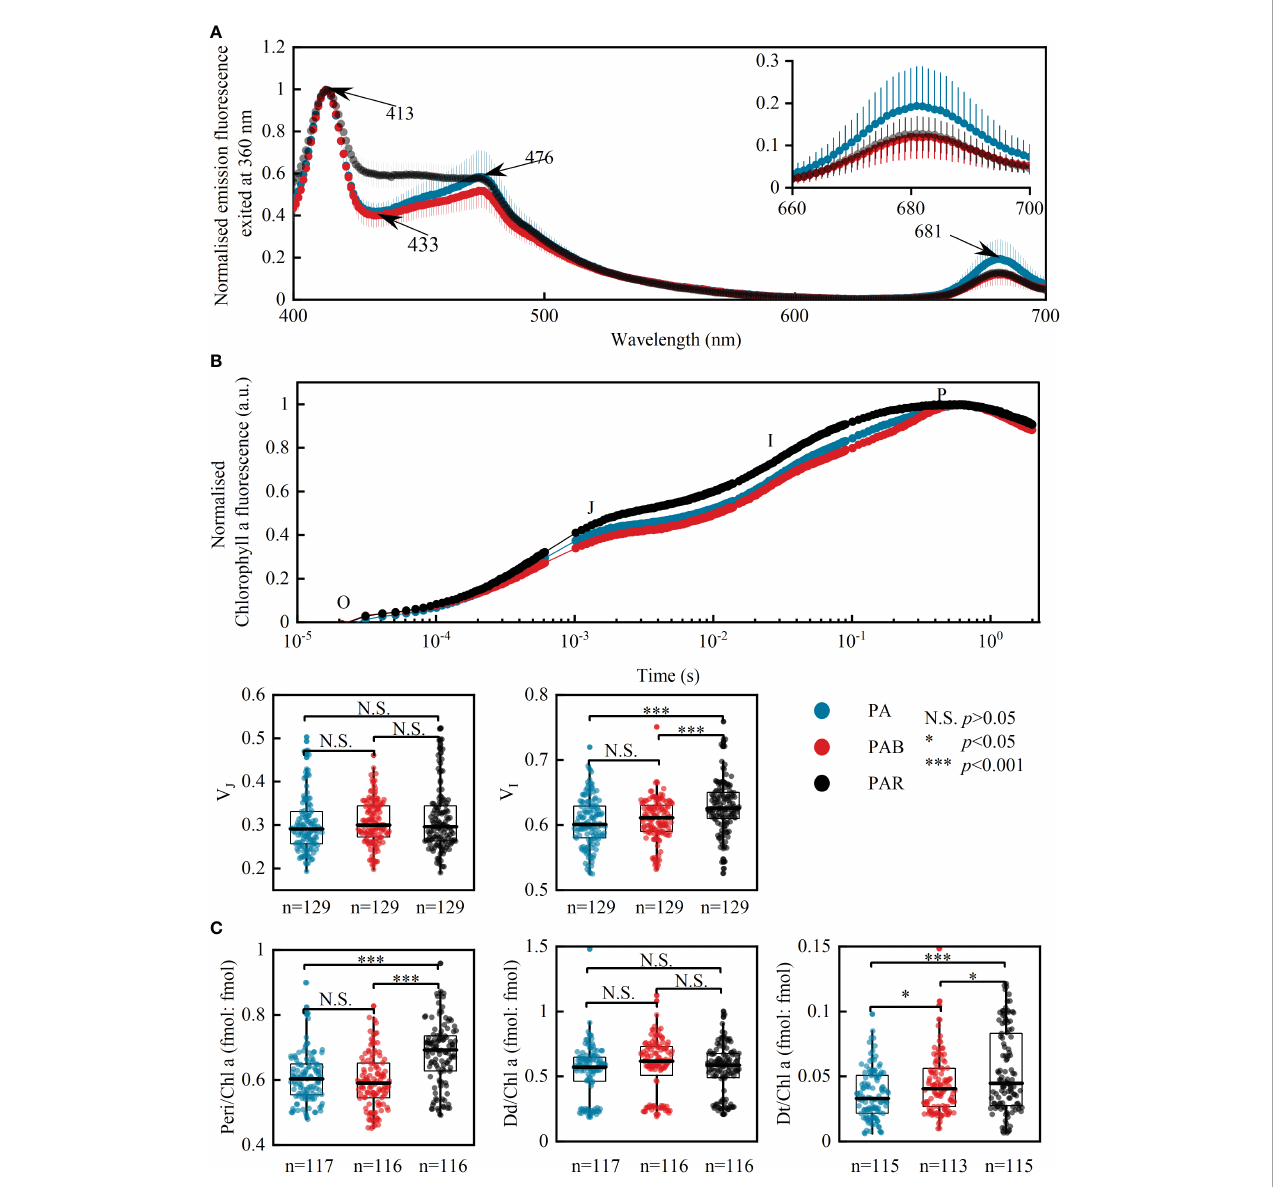
FIGURE 2 The effects of UVA on photosynthesis in P. lima complex and P. caipirignum . Mean fl uorescence emission spectra exposed to PA, PAB, and PAR excited at 360 nm (UVA waveband), n=15 (A) ; OJIP curves and related parameters V J and V I (B) obtained under different light treatments throughout the whole culture period. Ratios of peridinin (Peri), diadinoxanthin (Dd) and diatoxanthin (Dt) to chlorophyll a (Chl a) (C) . Due to similar responses of Chl a fl uorescence and pigment ratios to light treatments among fi ve strains of P. lima complex and P. caipirignum (strain SE10), all fi ve strains are pooled for light treatment analyses. N.S., non-signi fi cance, p > 0.05; *p < 0.05; ***p <